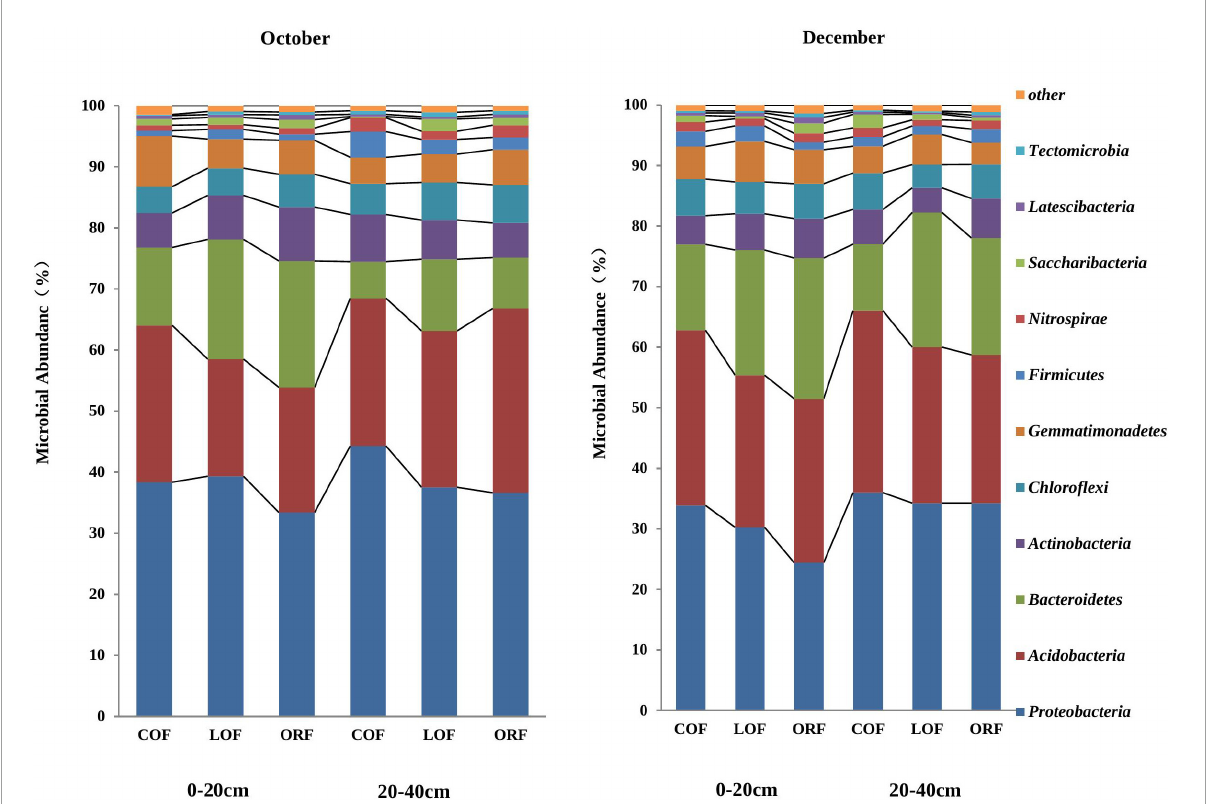
FIGURE3 Effect of different farming practices on soil microbial abundance at class levels within different soil depths and sampling months. Where, October and December- Months of soil sampling; COF, Conventional farming; LOF, Low input farming; ORF, Organic farming; 0–20 and 20–40 (cm)—Soil depth from where soil samples were